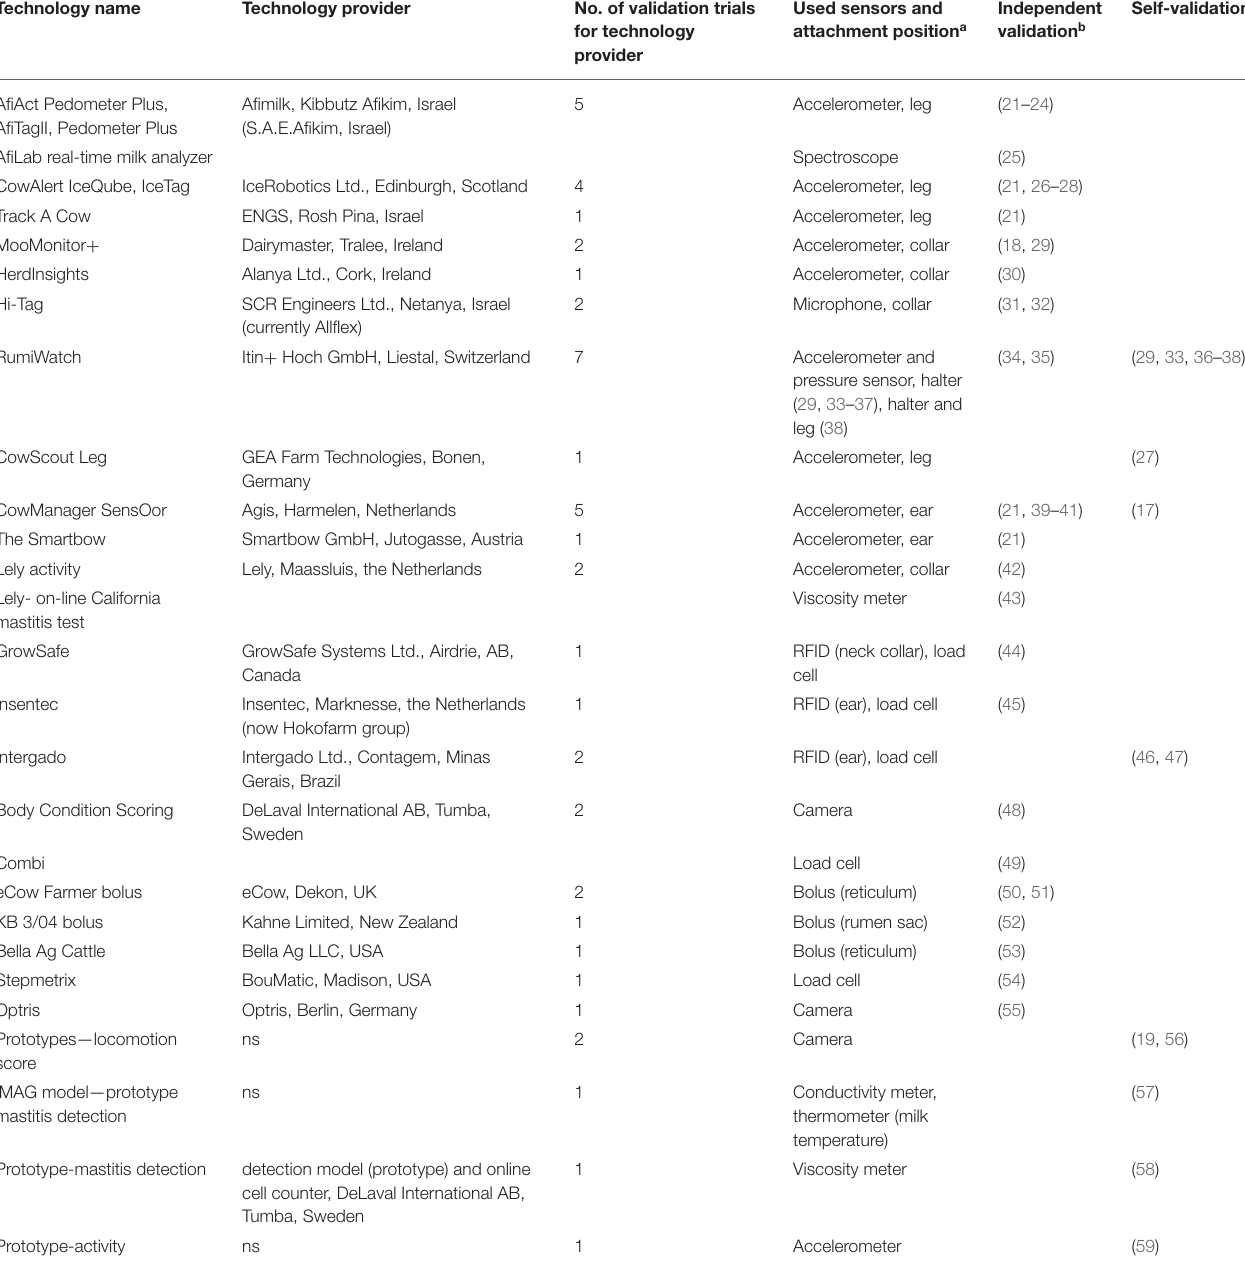
TABLE 1 | Summary of externally validated technologies with potential use for dairy welfare